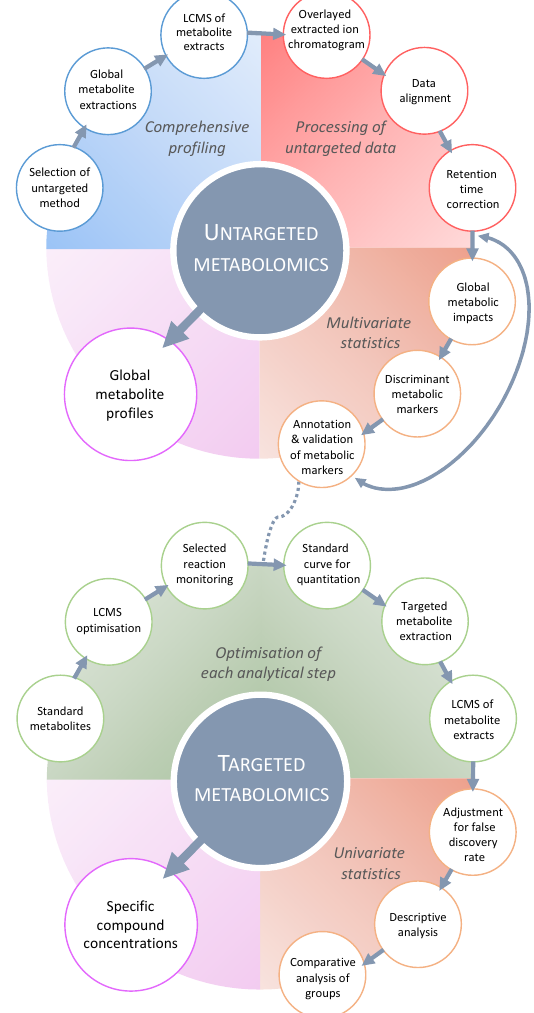
Figure 2. Typical LC-MS-based metabolomics workflow. Targeted metabolomics (bottom panel) aims to deliver quantitative concentrations of specific compounds using metabolite standards to